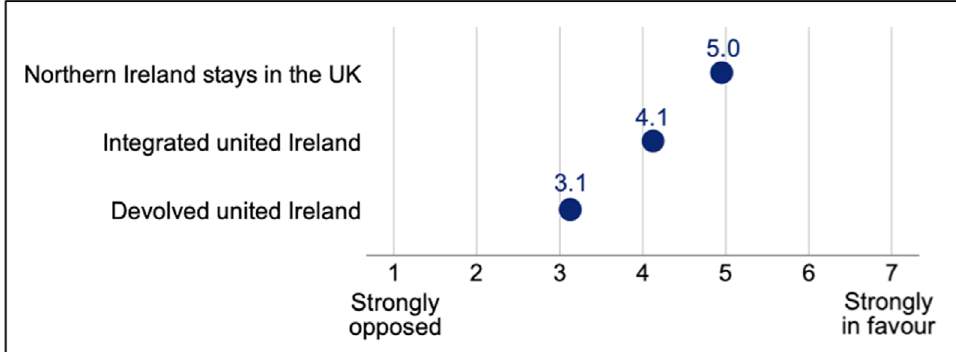
Figure 2: Mean favourability scores of each option among minipublic